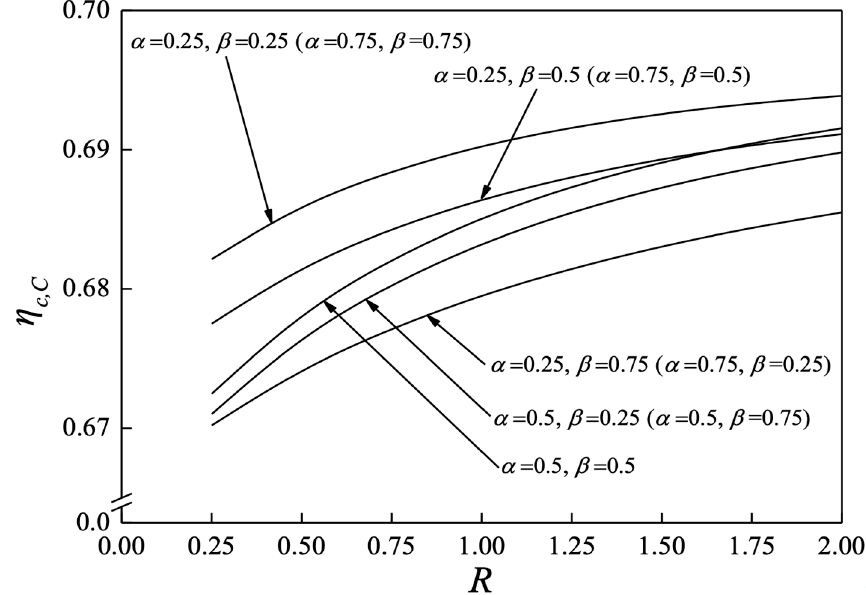
Figure 10. Effects of aspect ratio variations on the collector thermal efficiency.